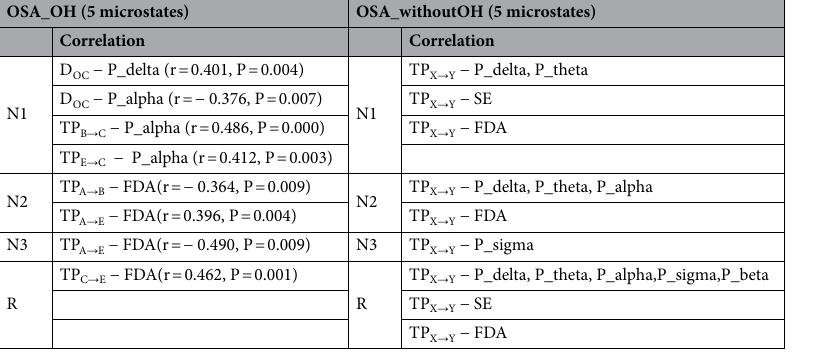
Table 7. Correlation between microstate parameters of 5 microstates and power, sample entropy and DFA in OSA_OH and OSA_withoutOH